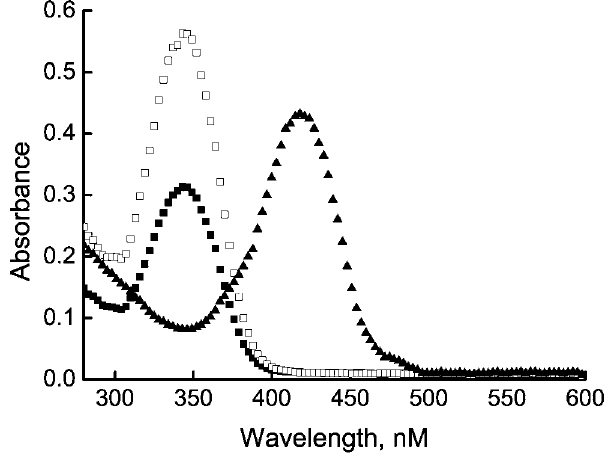
Figure 4. Absorbance of NBD chloride-treated purified OxyR. Air-oxidized OxyR ( & ), along with the CHP (10 mM) treated OxyR ( % ), shows maximal absorption at 347 nm. The shoulder at 420 nm is reduced OxyR ( m ) reacted with NBD chloride. The absorbance spectrum is from 285 to 600 nm.